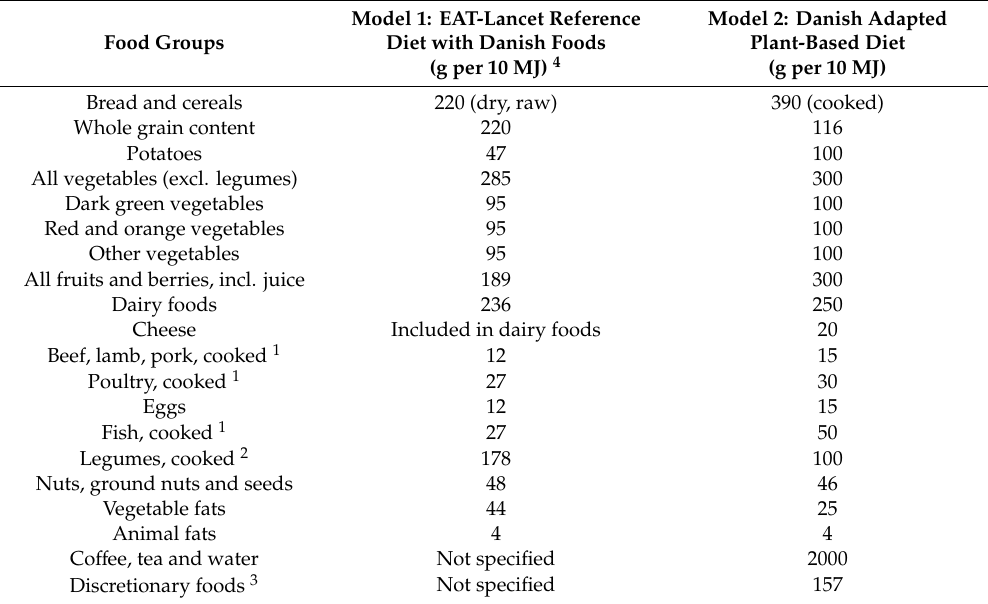
Table 1. Content of foods in the EAT-Lancet reference diet with Danish foods (Model 1) and in the Danish adapted plant-based diet (Model 2) per 10